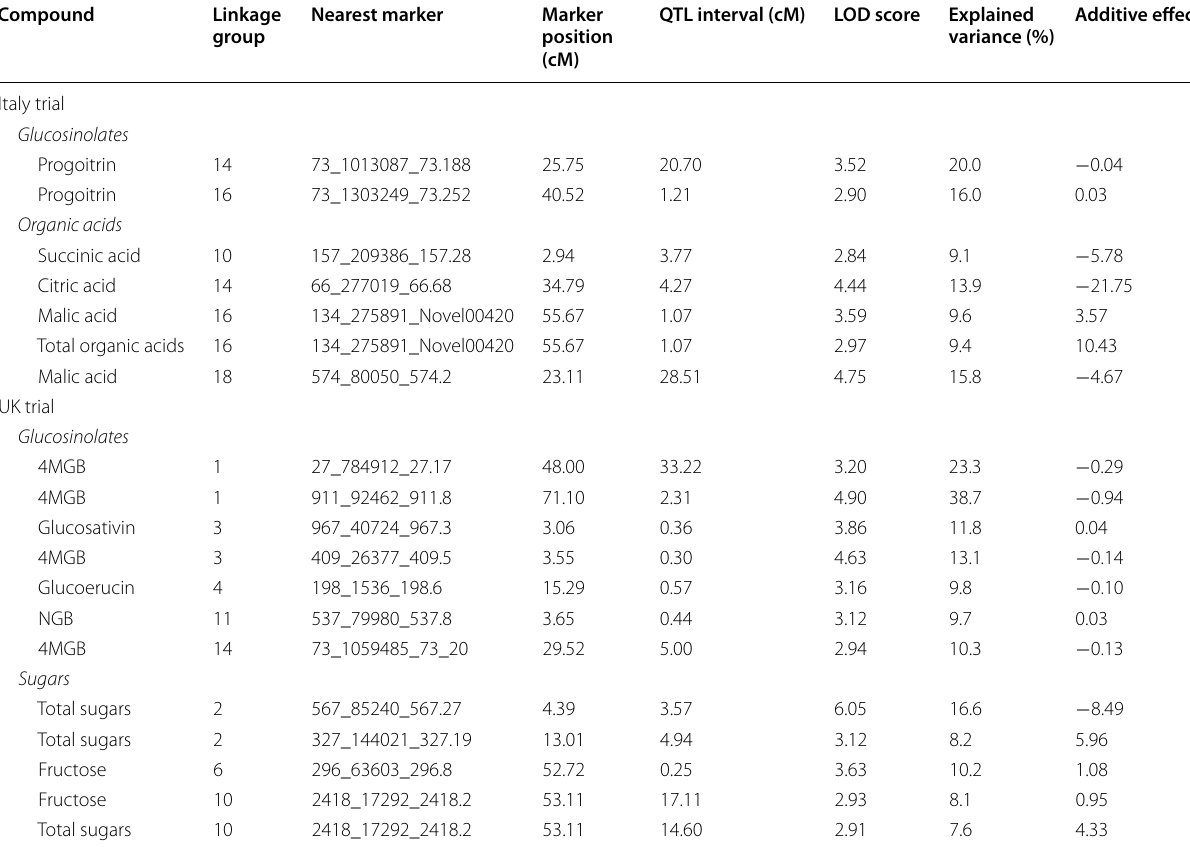
Table 2 Quantitative Trait Loci statistics for glucosinolates, sugars, and organic acids identified and quantified in a rocket mapping population ( n 139) grown in Italy and the United Kingdom =